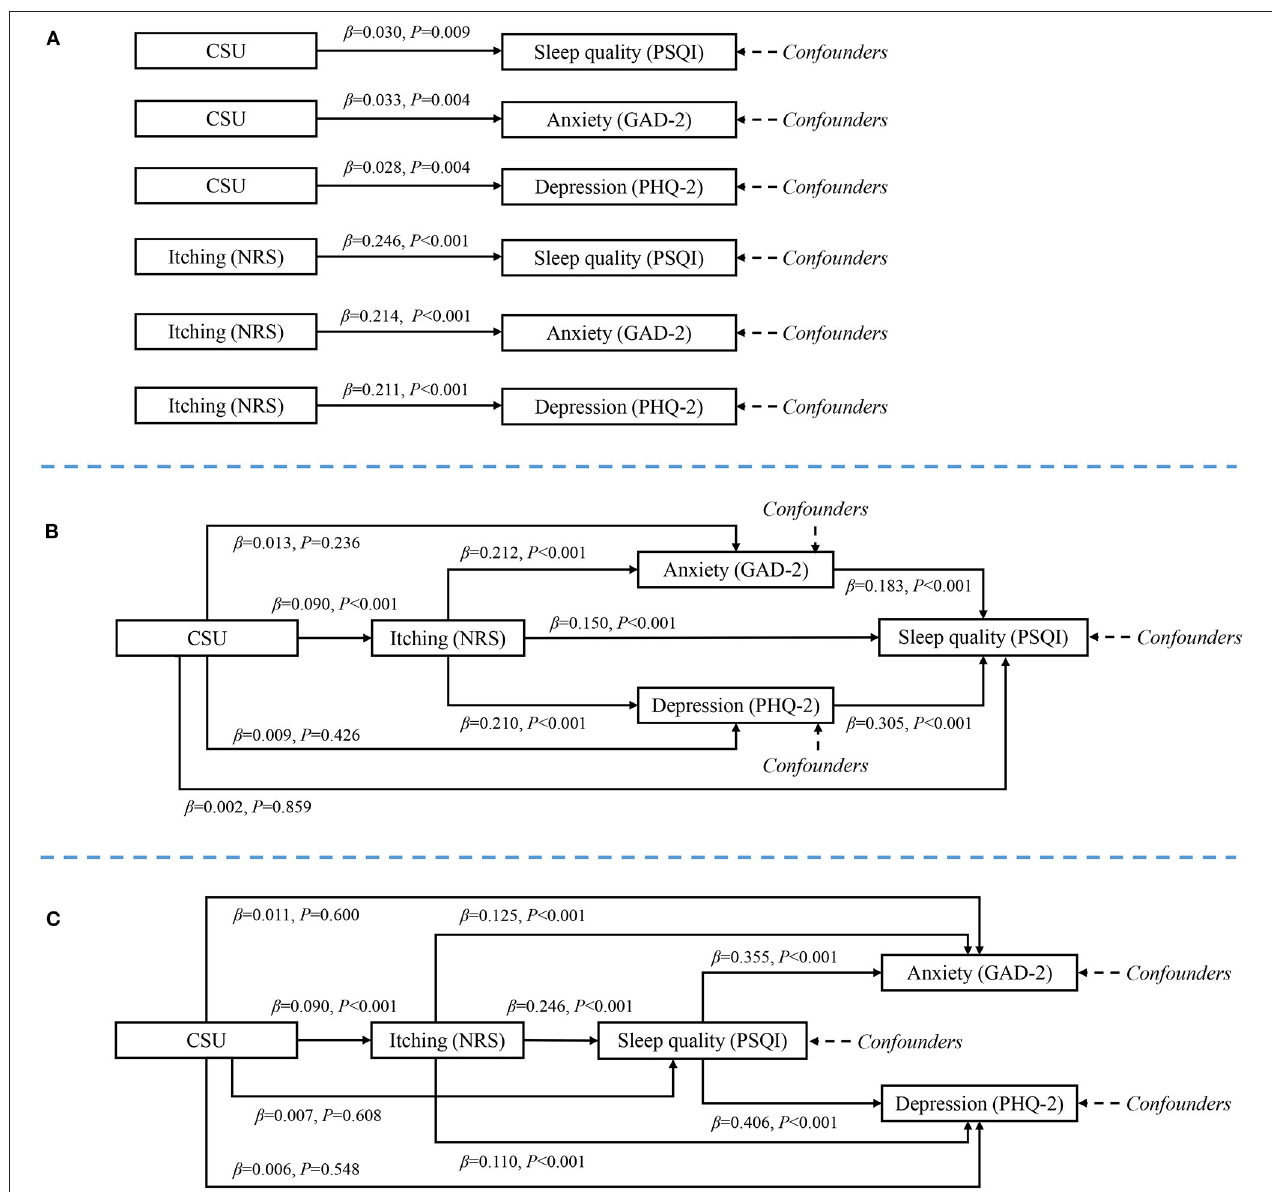
FIGURE 2 | Mediation model from chronic spontaneous urticaria to emotional problems. (A) Total effects, adjusted for confounders but not adjusted for mediators. (B) Direct and mediation effects of one-mediator model. (C) Direct and mediation effects of two-mediator model. Chronic spontaneous urticaria had significant total effect on sleep quality, anxiety and depression; but when mediators were modeled, urticaria had no significant direct effect on sleep quality, anxiety and depression. Itching and sleep quality had significant mediation